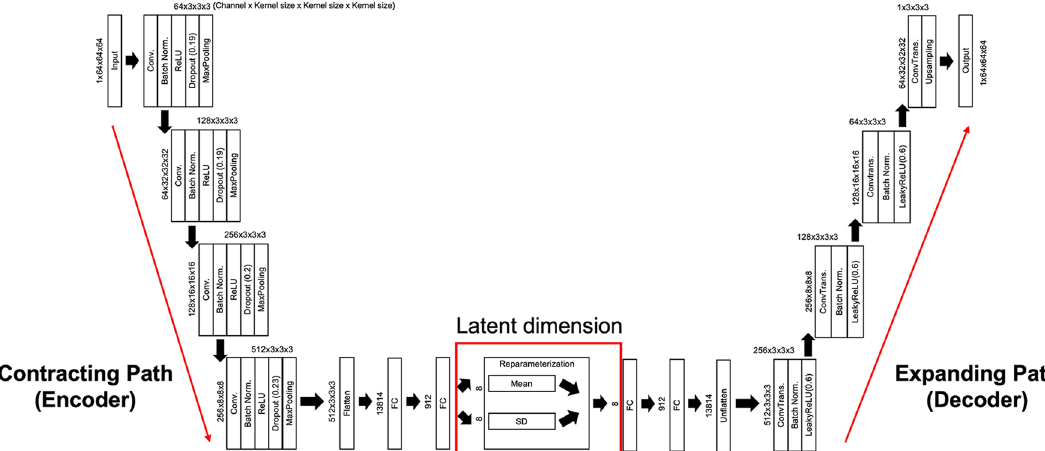
Figure 5. Schematic view of our proposed 3D VAE model, which consists of an encoder, latent dimension module, and decoder. Batch Norm., batch normalization; Conv, 3D convolution; ConvTrans, 3D transposed convolution; FC, fully connected; ReLU, rectified linear